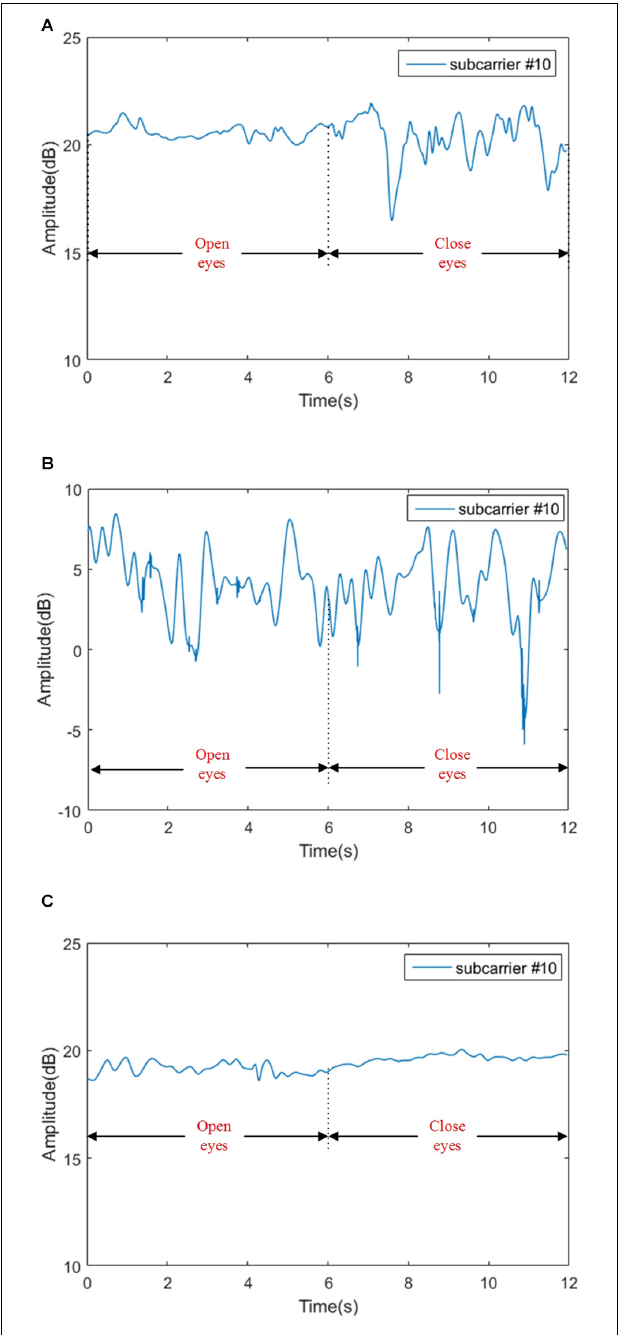
FIGURE 9 | Signal amplitudes for sensory ataxia subject, cerebellar ataxia subject and normal person in Romberg’s test. (A) Signal amplitudes for sensory ataxia subject, (B) signal amplitudes for cerebellar ataxia subject, and (C) signal amplitudes for normal